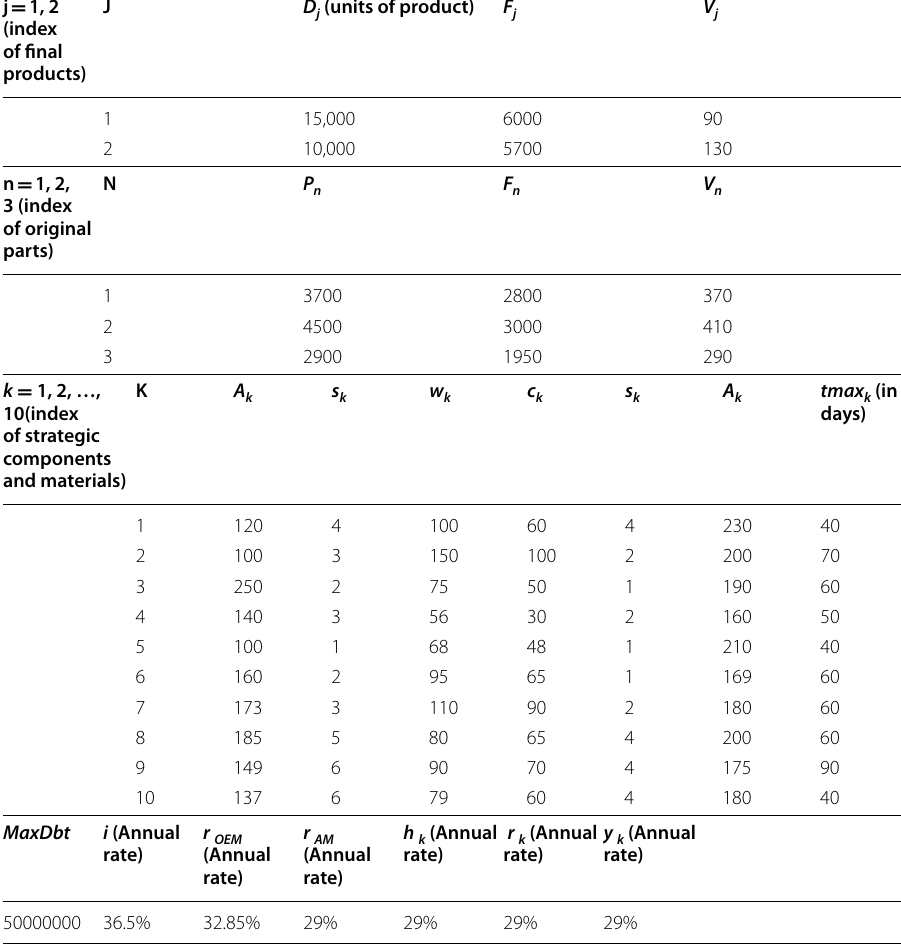
Table 4 Data from an OEM in the automotive supply chain for the model parameters (Prices are in terms of 1000 units of